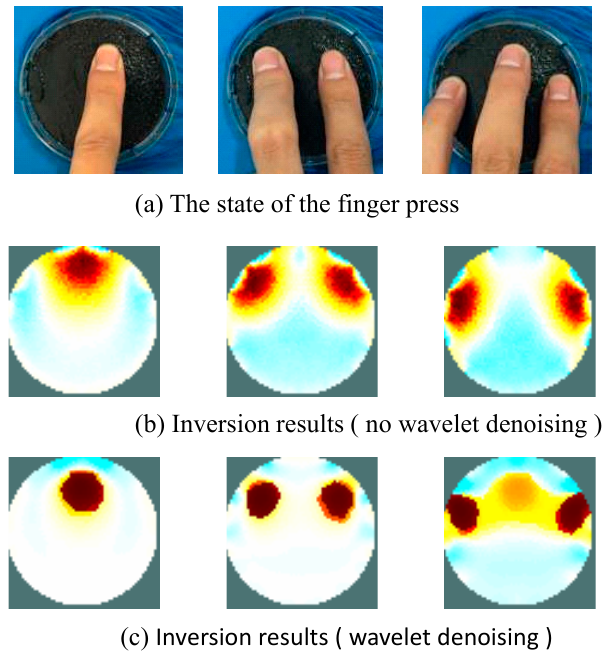
Figure 7. Experimental results of pressure distribution imaging.